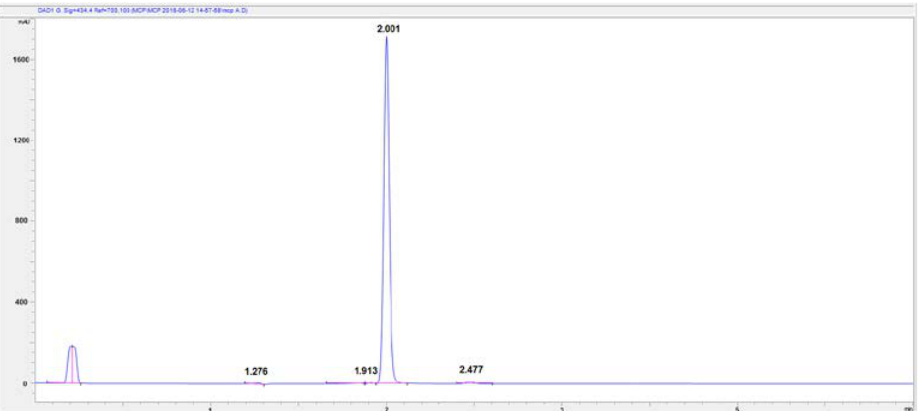
Figure 2. High-Performance Liquid Chromatography-Diode Array Detector (HPLC-DAD) chro- matogram of 2.5 mM mCP standard solution detected at 434 nm wavelength. Eluent composition: 70% H 2 CO 2 NH 4 0.5 M pH 8.0 and 30% CH 3 CN.